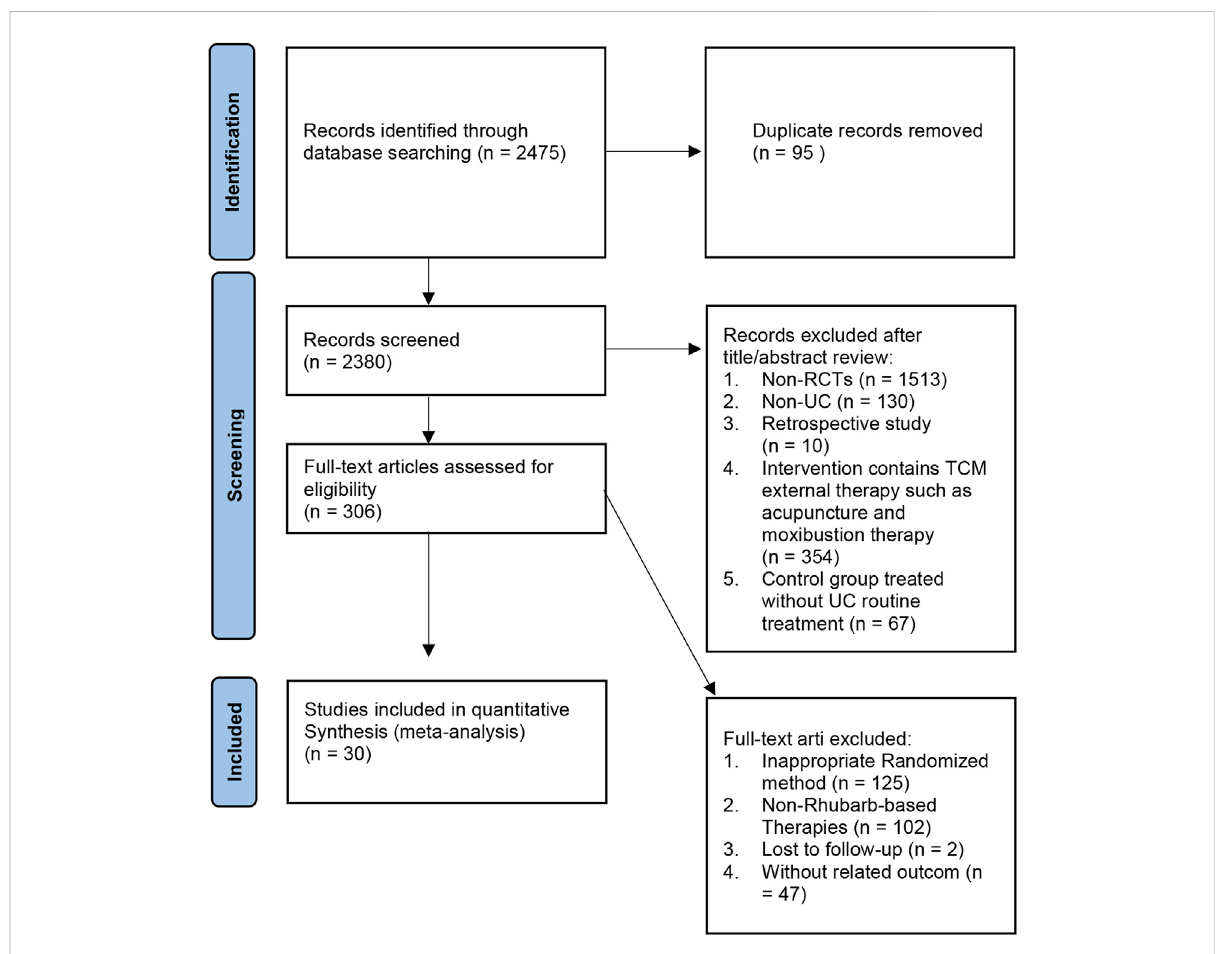
FIGURE 1 The fl ow of original literature